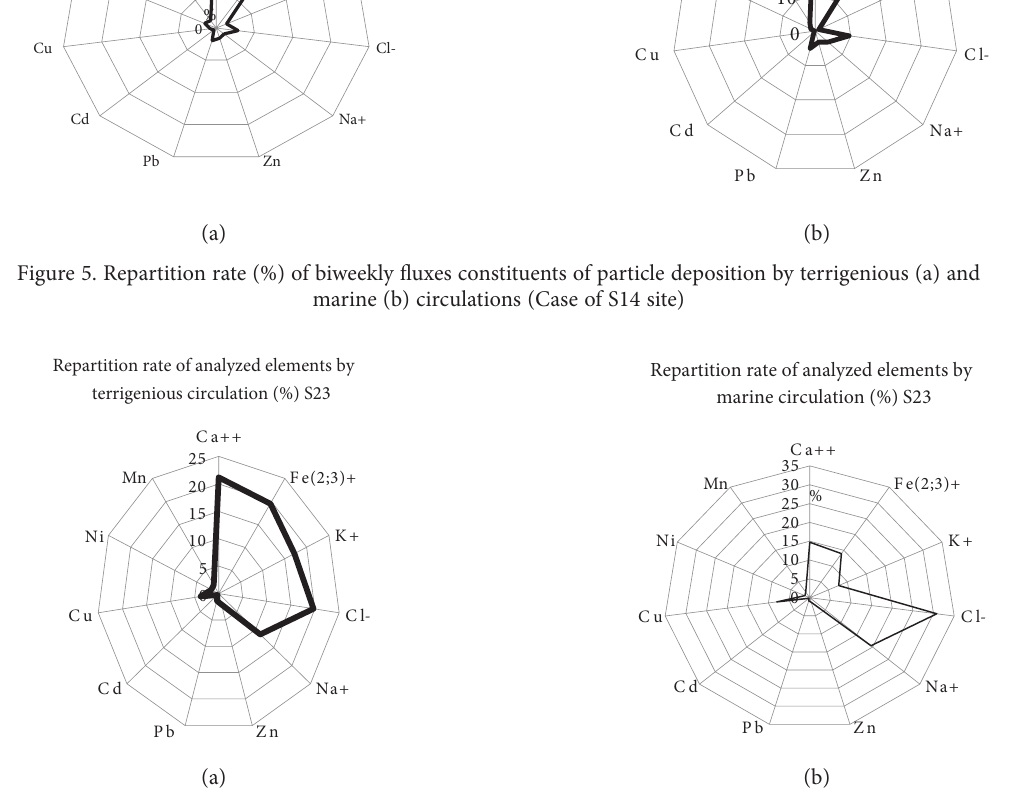
Figure 6. Repartition rate (%) of biweekly fluxes constituents of particle deposition by terrigenious (a) and marine (b) circulations (Case of S23